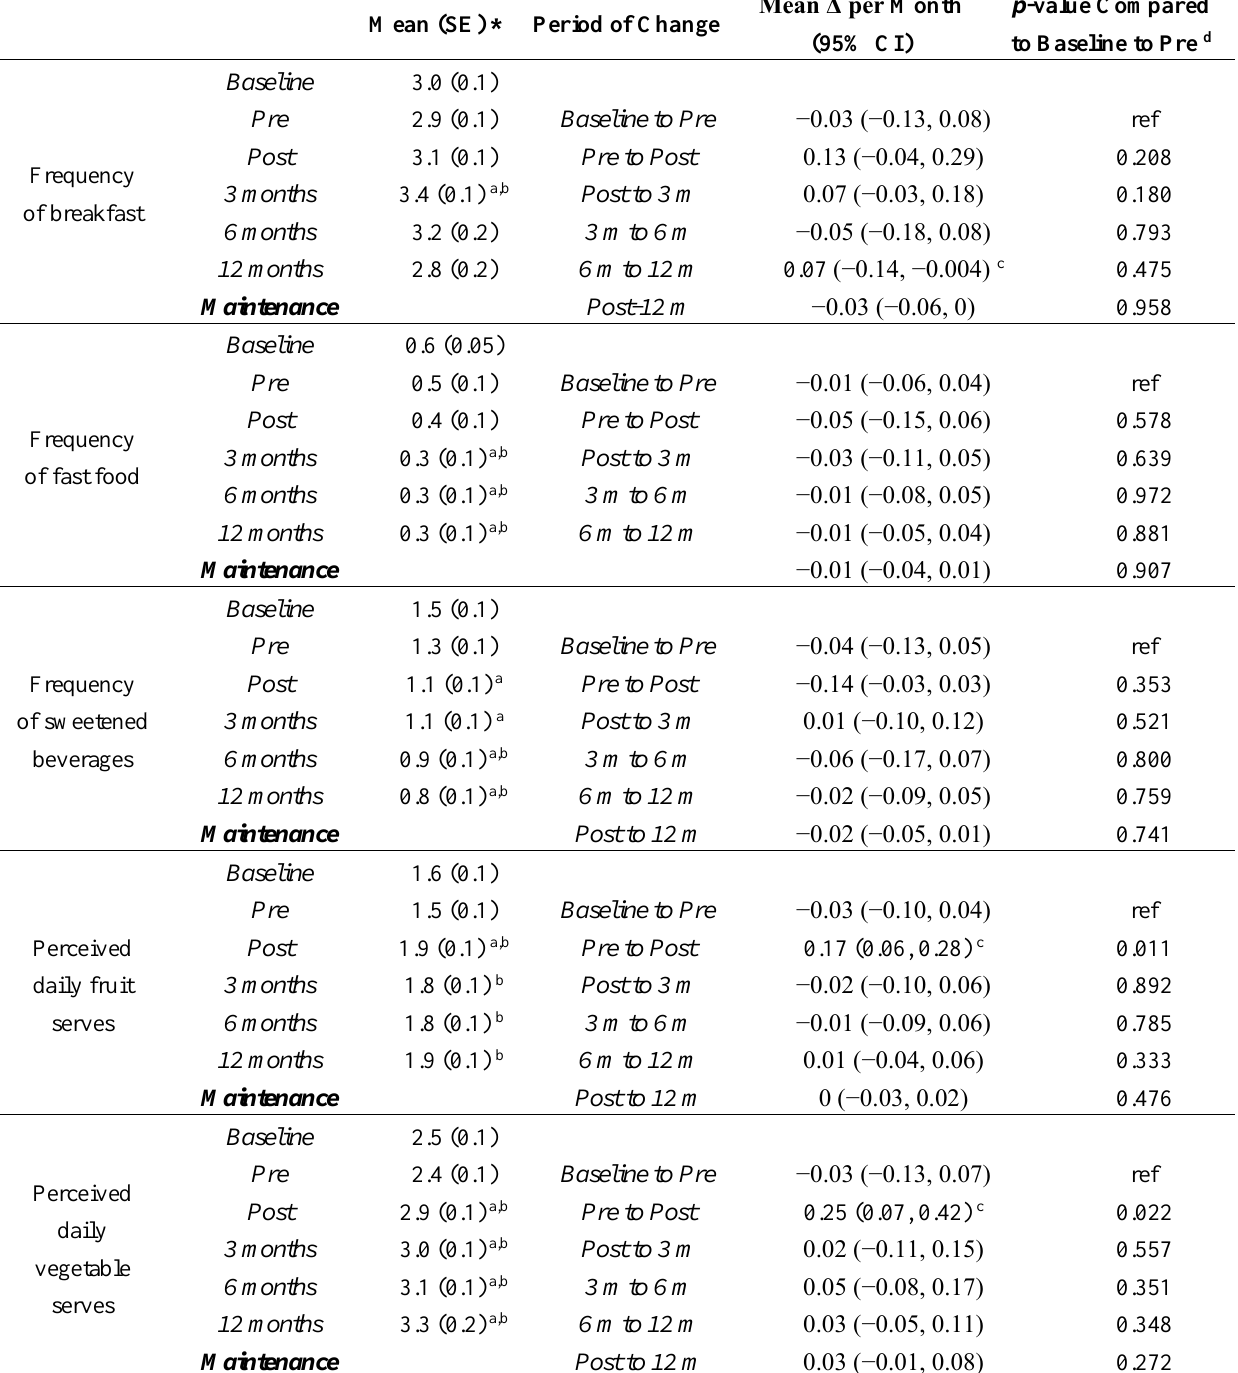
Table 1. Mean self-reported eating behavior point estimates and rates of change across intervention and follow up in a cohort of 58 overweight